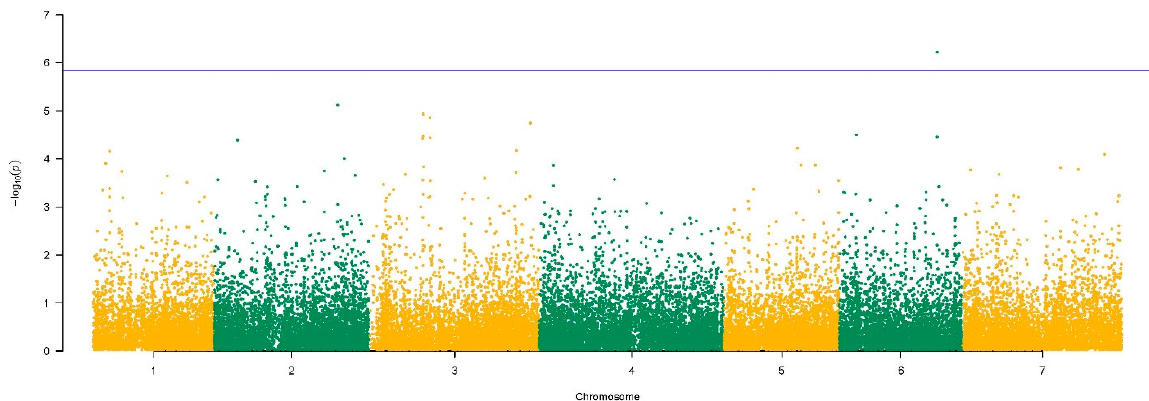
Figure 6. Manhattan plot of the GWAS results for BRR using MAGMA. The blue line refers to the Bonferroni threshold. On the x -axis, the 7 chromosomes are reported in alternating colours. Table 5. Genes associated with BRR identified using MAGMA ( − log 10 ( p -value) > 4.0). Chromosome number (Chr); Gene coordinate (bp) on the chromosome (Start and Stop); numbers of SNPs within the gene (N SNP); p -value for testing the association of the genes with BRR ( p -value). Gene ID Chr Start N